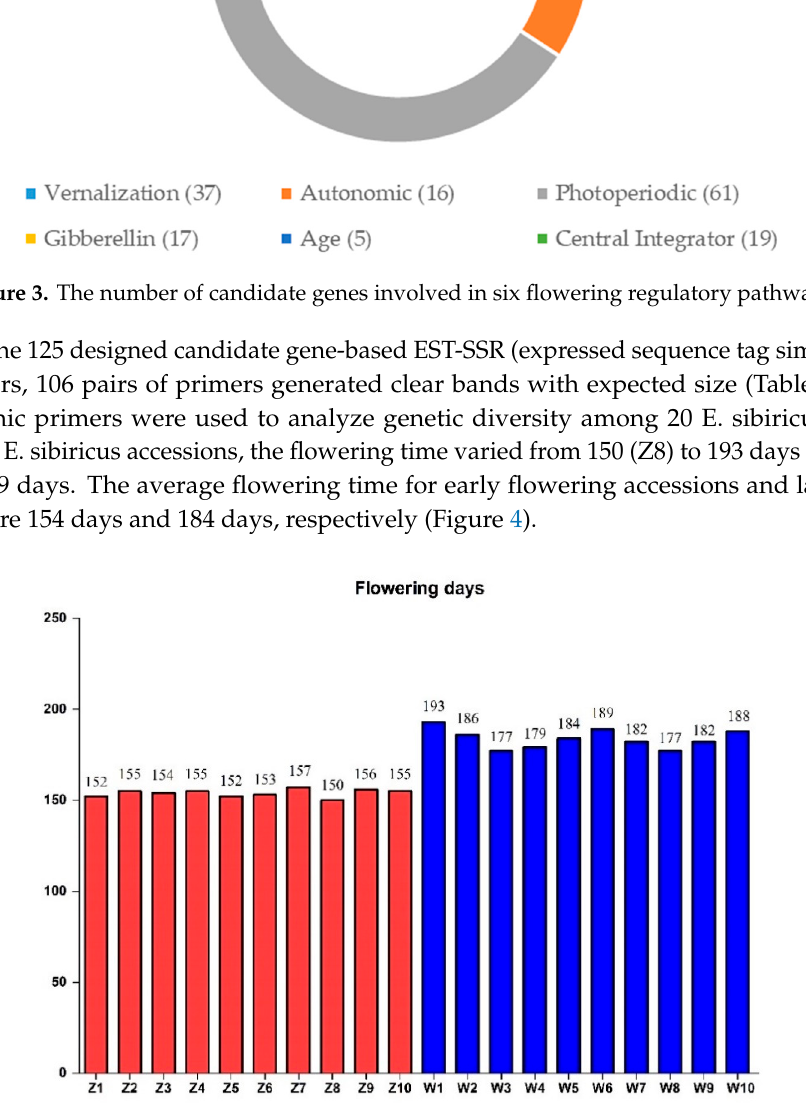
Figure 3. The number of candidate genes involved in six flowering regulatory pathways.